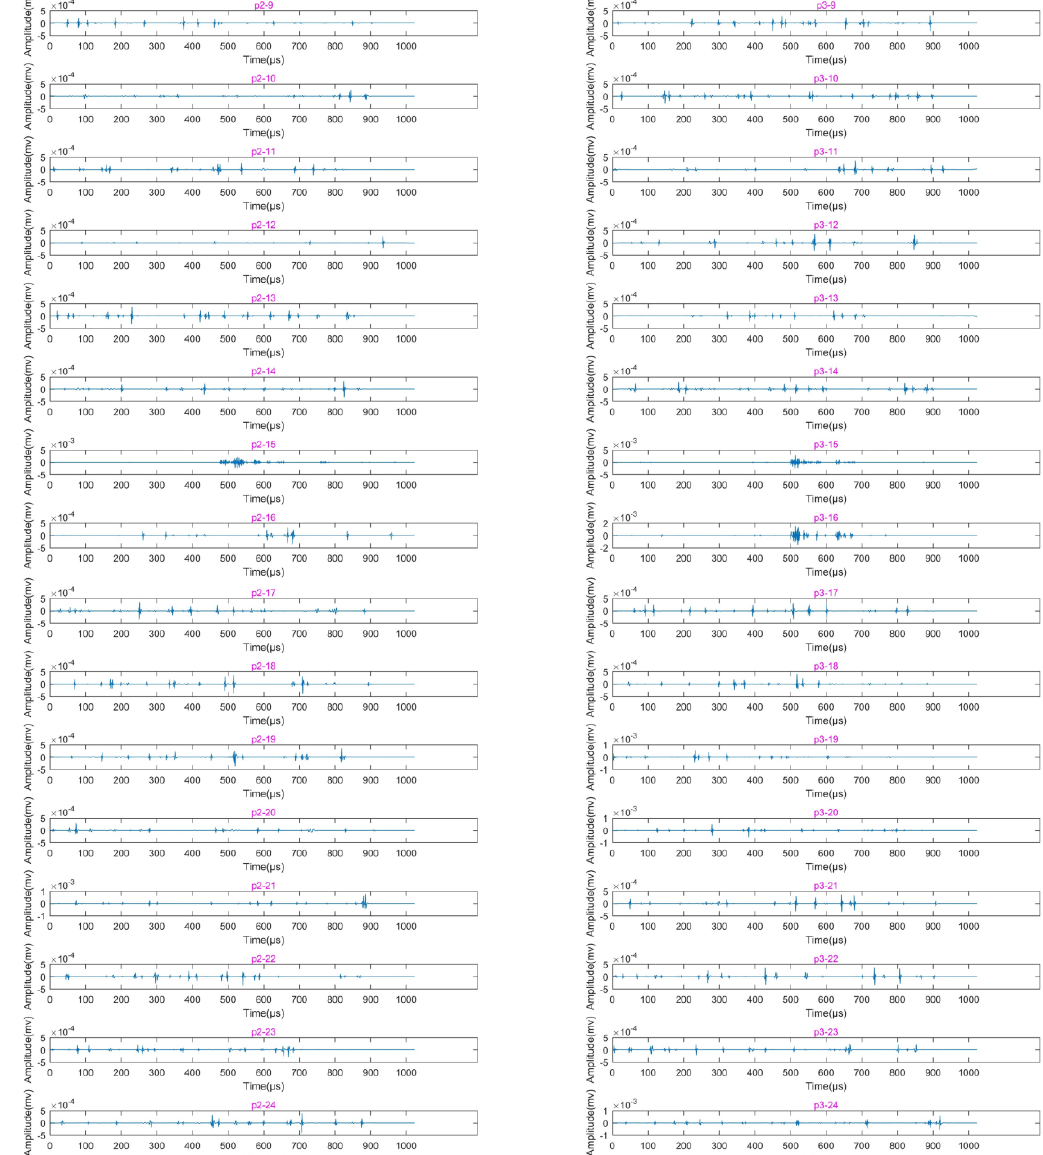
Figure 9. Reconstructed waveforms of signals with largest centroid frequency collected by sensors P2 and P3 in working cases 9 – 24 after lifting wavelet decomposition and filtering out the first-layer low-frequency components. The waveforms of P2 – 15, P3 – 15, and P3 – 16 correspond to